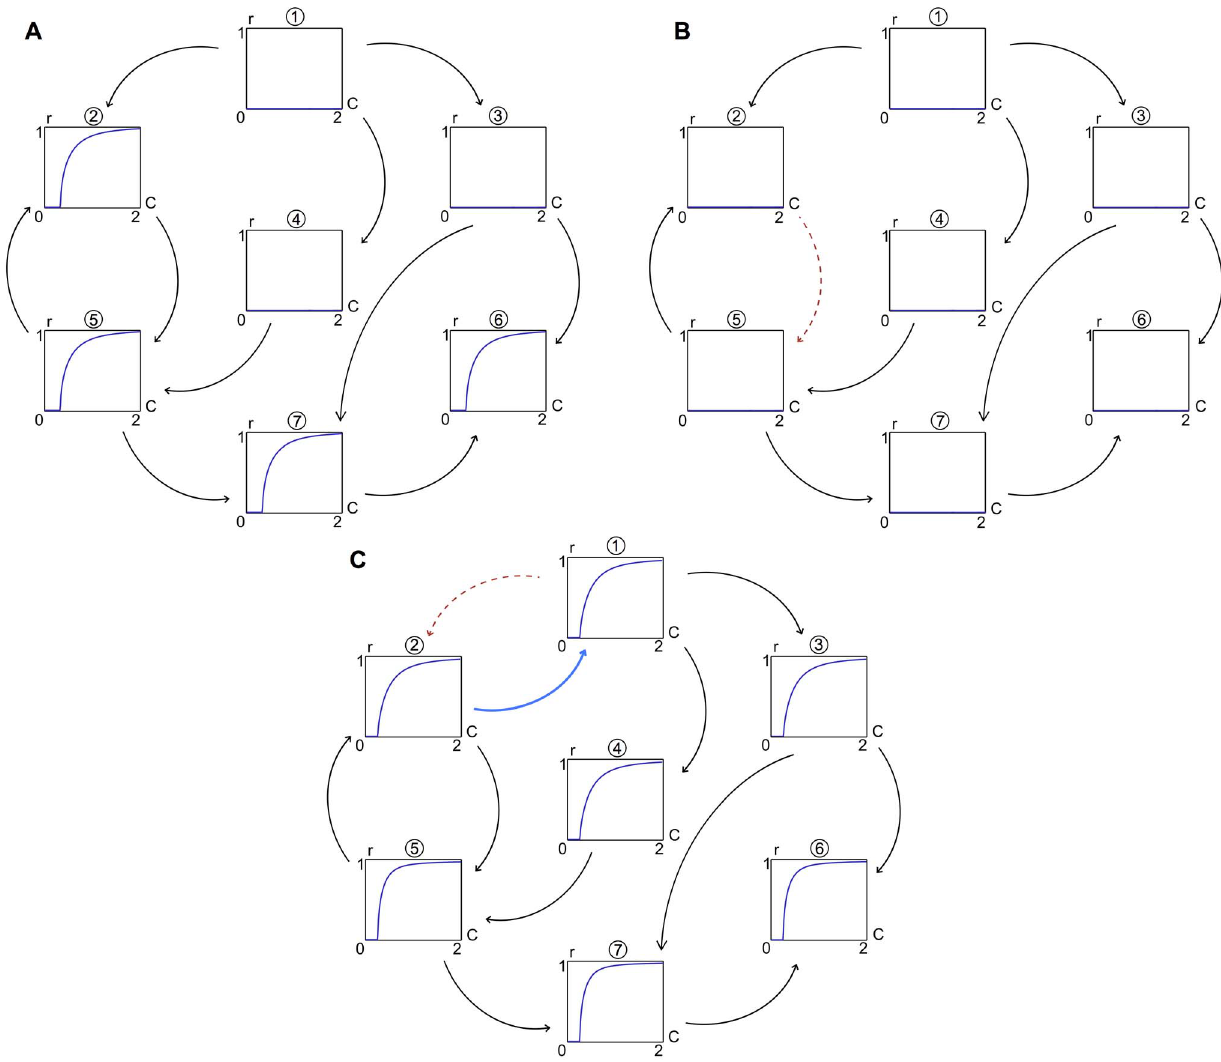
Figure 7. Illustration of how subtle changes in the network structure affect the ability of the network to synchronize. A : An arbitrarily chosen network shows partial synchronization due to a cycle ( 2 < 5 ) and two adjacent nodes (6,7). B : By removing one connection (red, dashed) the cycle is broken and the network loses its capability for synchronization. C : By reversing the connection between 1 and 2 (blue, bold), the network from A becomes globally synchronous for large enough C . Numerical results are in agreement with analytical results, but omitted here. The intrinsic coupling constant of all nodes is set to K ~ 0 : 8 .